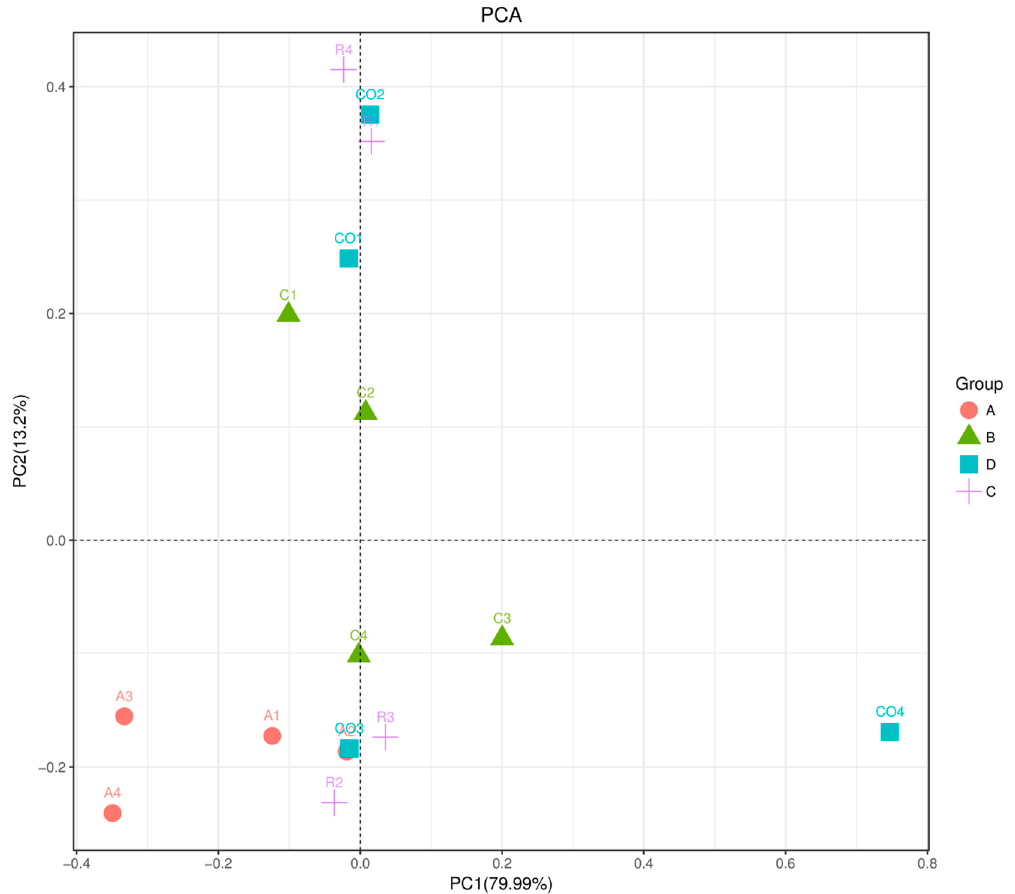
Figure 8. Samples in a two-dimensional sorting graph in PCA analysis. Note: Each point represents a sample. Points of di ff erent colors belong to di ff erent samples (groups). The closer the distance between the two points, the higher the similarity of microbial community structures between the two samples, and the smaller the di ff erence. The percentage in parentheses in the axis represents the proportion of the di ff erence in the raw data that the corresponding principal component can interpret. (A: alfalfa, C: cornstalk, R: rice straw, CO: